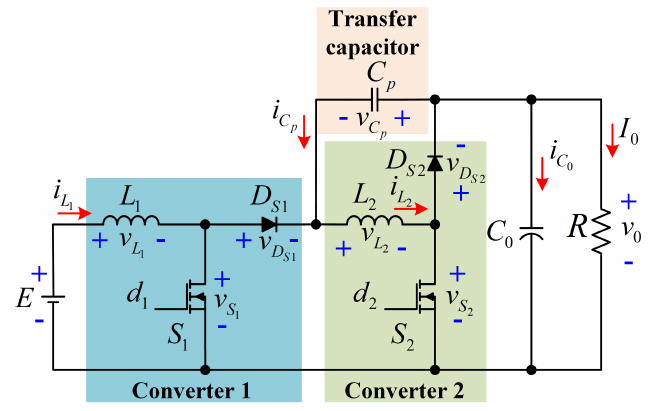
Figure 3. Quadratic boost converter with non-series power